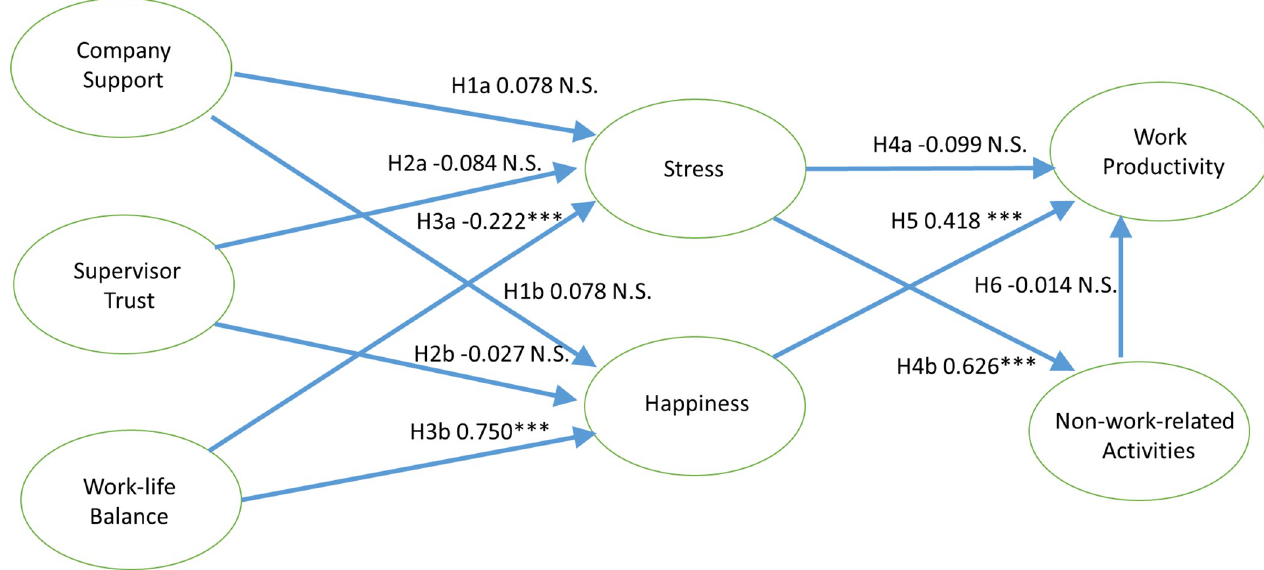
Fig 1. Results of the research model testing. N.S. represents not significant. ��� indicates a p -value less than 0.01. The numbers to the right of the hypotheses’ numbers are the standardized path coefficients.